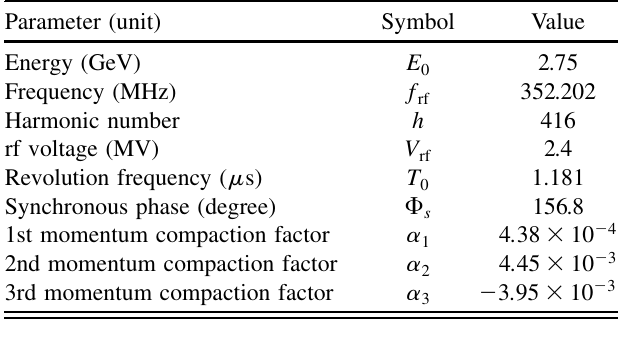
TABLE I. Main experimental parameters for the nominal op- tics of the SOLEIL storage ring operation in 2007 as calculated with the BETA